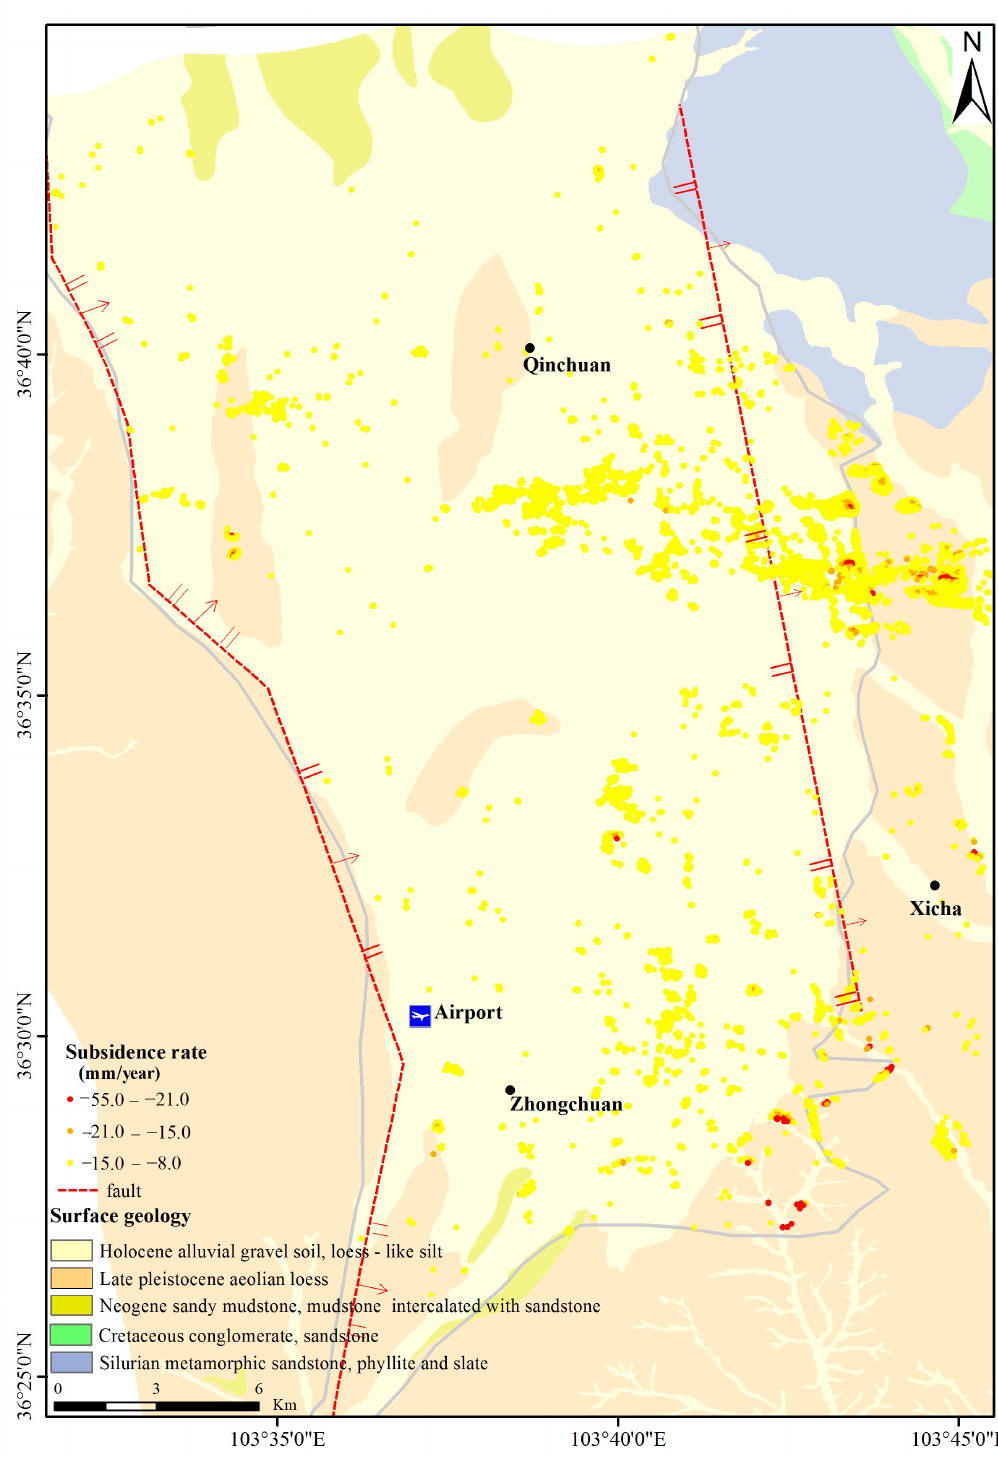
Figure 11. InSAR-derived average annual subsidence rates in LZND, with surface lithology units from the 1:100,000 geological map superimposed.